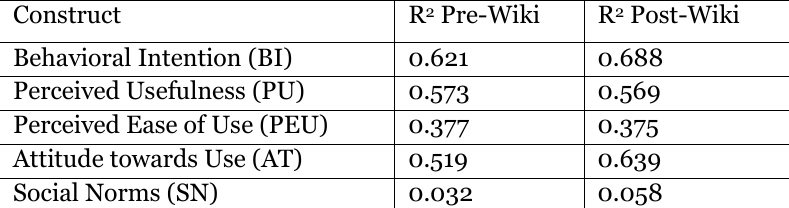
R-Squared Values for Both Scenarios